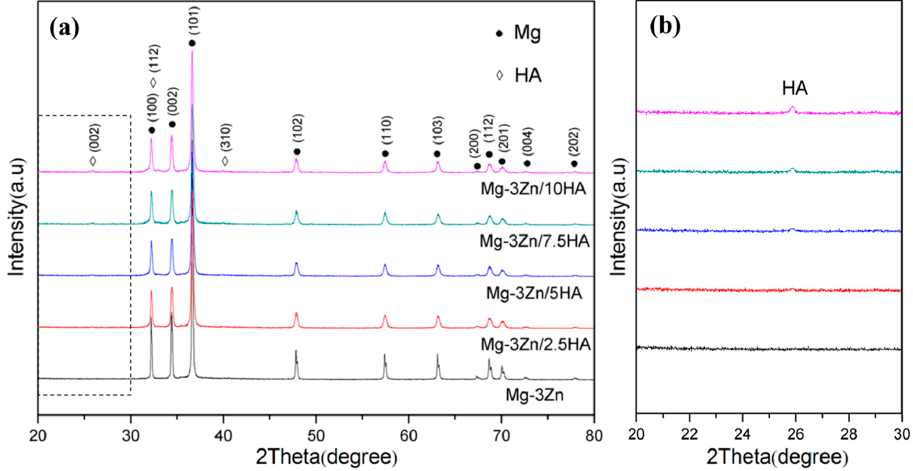
Figure 2. The X-ray diffractometer (XRD) spectra of the Mg-3Zn/ x HA composites with 2 θ range of ( a ) 20°–80° and ( b ) 20–30°.